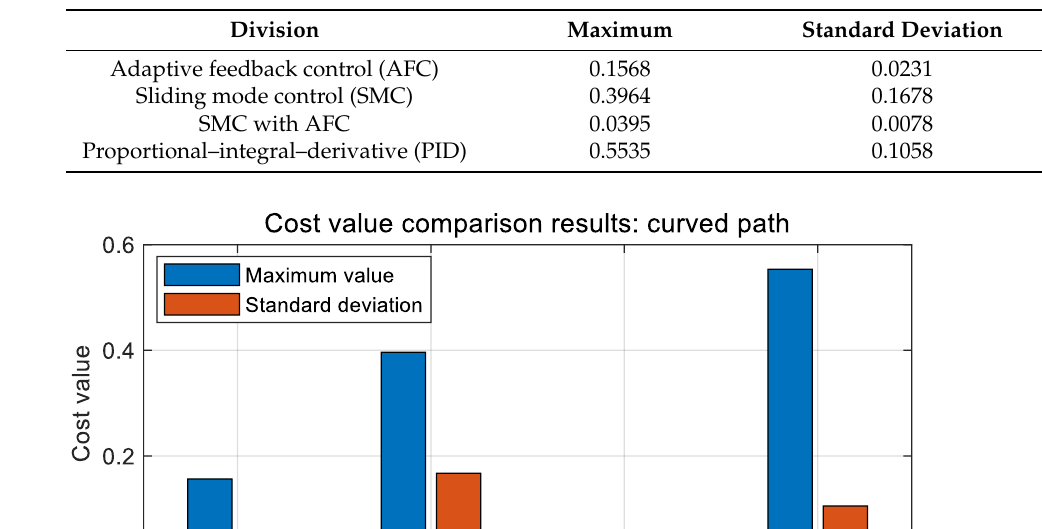
Table 4. Results of cost value comparison for the curved path tracking.